Question: Sum up the contents of this chart in one sentence.
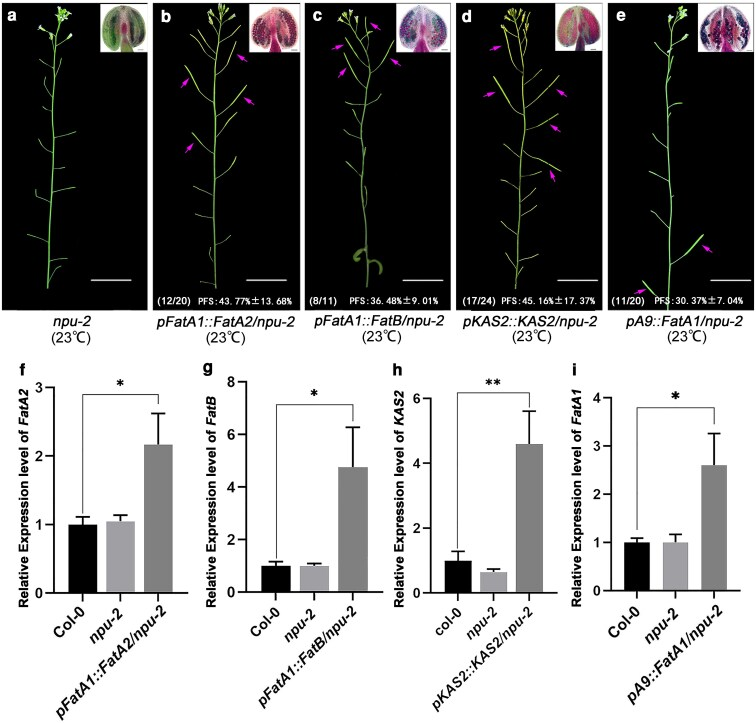
Answer: Restoration of npu-2 fertility by overexpression of FatA2 , FatB and KAS2 . a to e) Phenotypic analysis of npu-2 mutant a) and transgenic lines ( pFatA1::FatA2 / npu-2 b), pFatA1::FatB / npu-2 c), pKAS2::KAS2 / npu-2 d), pA9::FatA1 / npu-2 e)). Magenta arrows indicate elongated, fertile siliques. Alexander staining was used to assess pollen viability. Numbers indicate fertile transgenic lines (eg 12/20 denotes 12 fertile lines out of 20 independent transgenic plants). The percentage of fertile siliques (PFS, mean ± Sd ) was calculated from 3 independent fertile transgenic lines ( n ≥ 20 siliques per line). Scale bars: 2 cm (adult shoots) and 50 μm (anthers). f to i) Relative expression levels of fatty acid biosynthesis genes in npu-2 transgenic plants. Data represented mean ± Sd from 3 biological replicates. Statistical significance was assessed using a two-tailed t -test (* P < 0.05; ** P < 0.01; *** P < 0.001).